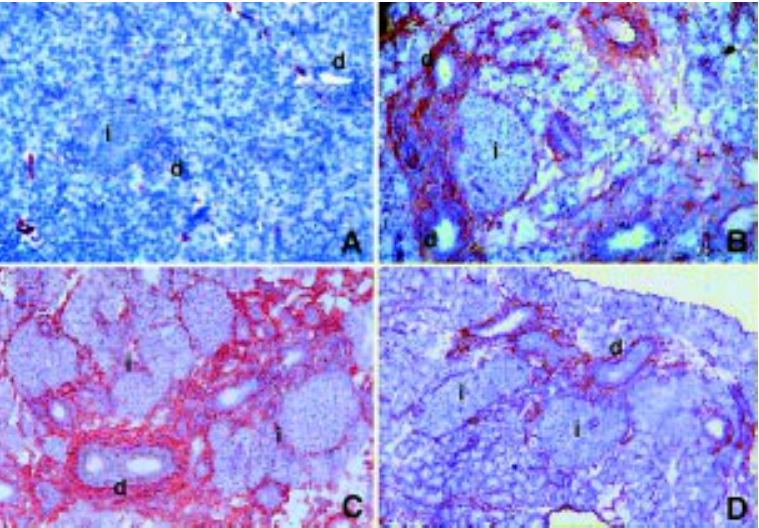
Figure 2 - A , Scavenger BM8 + macrophages are present in the pancreas of control strains, at 2 weeks of age, and are scattered throughout the exocrine tissue and/or are in close contact to ducts (d) and islets (i) (320X). These cells are also observed in similar localizations in NOD mice; B , C , and D correspond to fibronectin (320X), collagen I (320X) and TR-7 (fibroblast-like cells) (200X), respectively, in the pancreata of one-week-old NOD mice. These molecules are labeled in perivascular, periductular and peri-islet localizations, as for BM8 + macrophages. Control strains show usually thinner labeling in the same localizations (data not